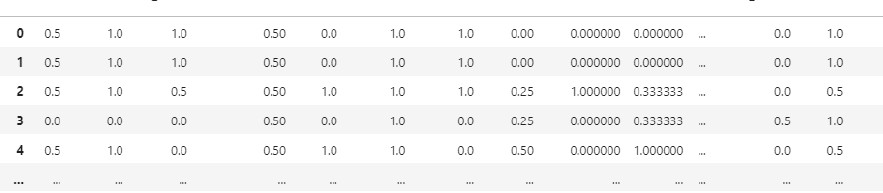
Figure 1. Offline after normalization.